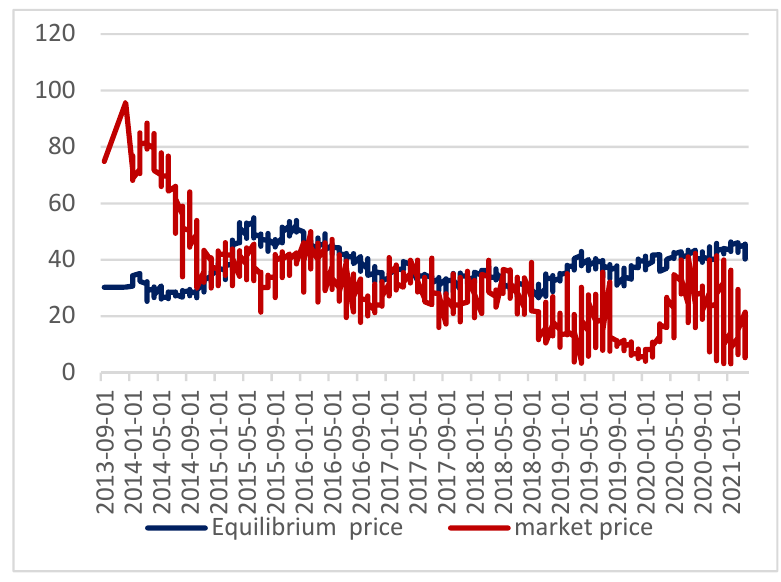
Figure 4. Equilibrium price and market price.